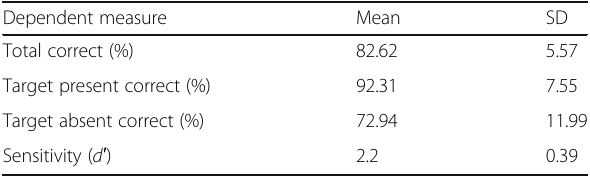
Table 3 Experiment 2: Accuracy and sensitivity for the detection task for the echocardiographers viewing each movie for 2 s ( n =